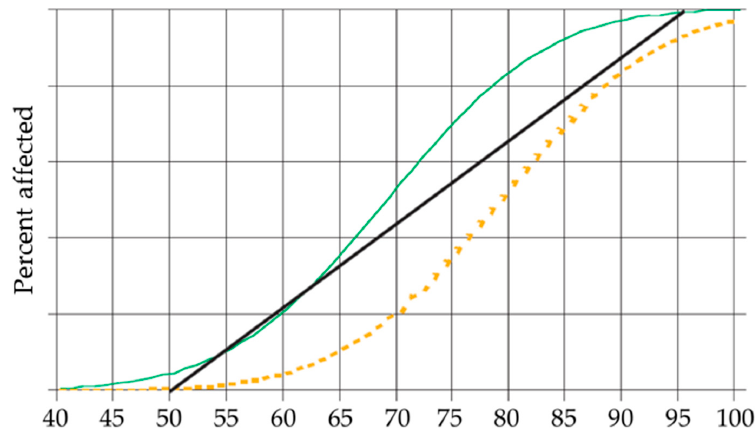
Figure 1 . Hypothetical exposure–risk curves and estimated percentages of affected people [33]. Table 2. Health risk of noise-induced cognitive impairment (NICI).